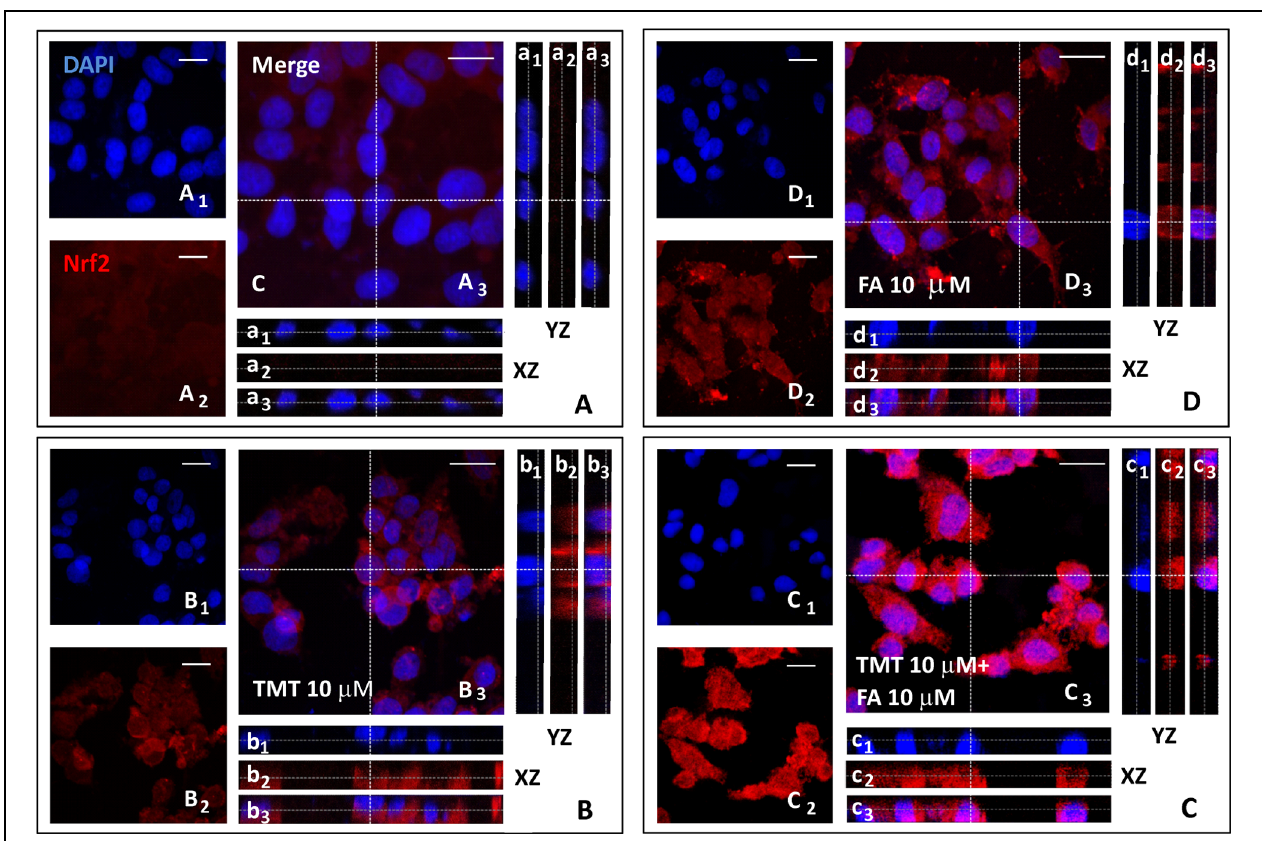
FIGURE 3 | Ferulic acid induces Nrf2 activation and translocation into the nucleus. (A–D) Representative images from four independent immunofluorescence experiments in which we performed a double-labeling with DAPI (A 1 –D 1 ) and an anti-Nrf2 antibody (A 2 –D 2 ) . Merged images are shown in (A 3 –D 3 ) . XZ and YZ cross-sections in the boxes (referred to the dashed lines) from the confocal Z -stack acquisitions illustrate cytosolic or nuclear fluorescence signal(s) (XZ and YZ boxes: a 1 –d 1 refer to DAPI staining; a 2 –d 2 : refer to Nrf2 fluorescence; a 3 –d 3 : Merge). In cells treated with TMT, a strong Nrf2 activation was detected which, however, remains mainly confined in the cytoplasm (b 1 –b 3 in B) . In TMT + FA treated cells, there was a further cytoplasmic enhancement of Nrf2 expression compared to TMT alone which also translocates into the nucleus as indicated by Z -stack acquisitions (c 1 –c 3 in C) . FA administration (10 μ M) induced an endogenous antioxidant response leading to a strong increase in Nrf2 expression in the cytosol (d 1 –d 3 in D) compared to Control (a 1 -a 3 in A) . Scale bar: 20 μ m. For further information see